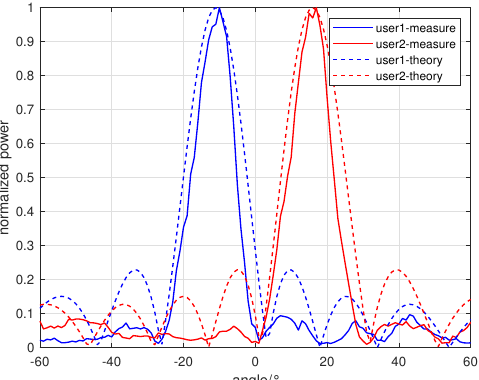
Figure 11. The measured and theoretical beam patterns of the given two users scenario.